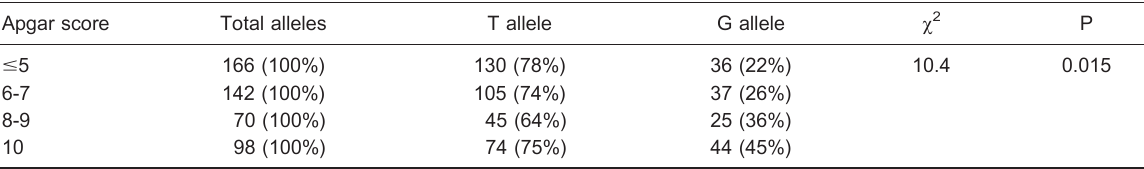
Table 2. Allele distribution analysis of NOS3 rs1808593 polymorphism and Apgar score. Apgar score